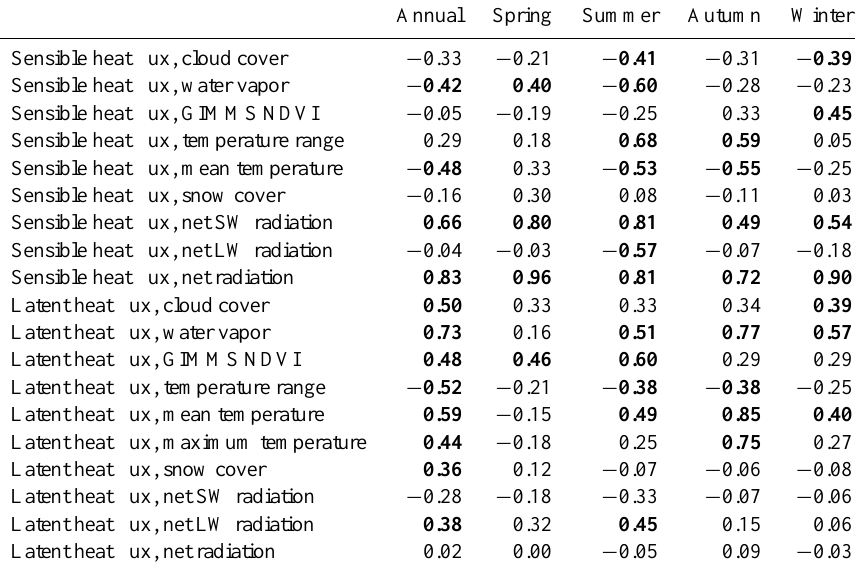
Table 6. Correlation coefficients between the annual and seasonal sensible and latent heat-flux anomalies from the fused data and surface and atmospheric anomalies over the TP (net shortwave (SW) and long wave (LW); all-wave radiation are from Shi and Liang, 2013a); p value<0.1 are in